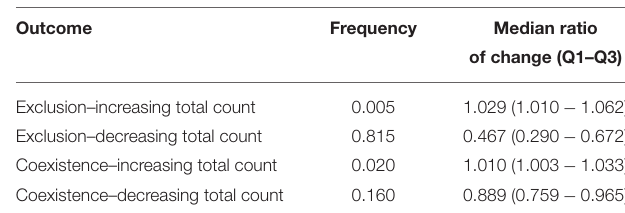
TABLE 5 | The observed frequencies of the possible outcomes of successful superinfection, and the median and interquartile range of the ratio of change in the uninfected target cell count for each case, calculated from 20,000 simulation runs with successful superinfection (50% of the total number of runs) in the multiple target cell types